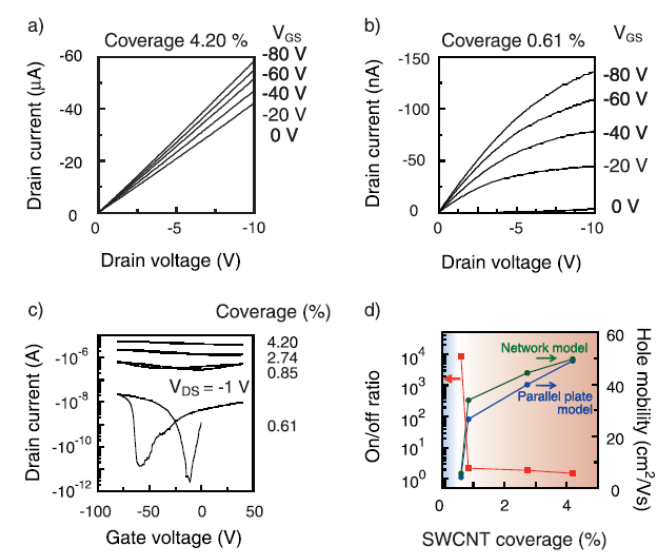
Figure 8. Inkjet-printed carbon nanotube thin-film transistor characteristics [62]. Figure ( a ) shows the output characteristics of the print with higher areal coverage, while figure ( b ) shows the output characteristics of the print with lower coverage. Figures ( c , d ) show the transfer characteristics of the prints and the on-off ratio dependence on coverage, respectively. Used with permission from John Wiley and